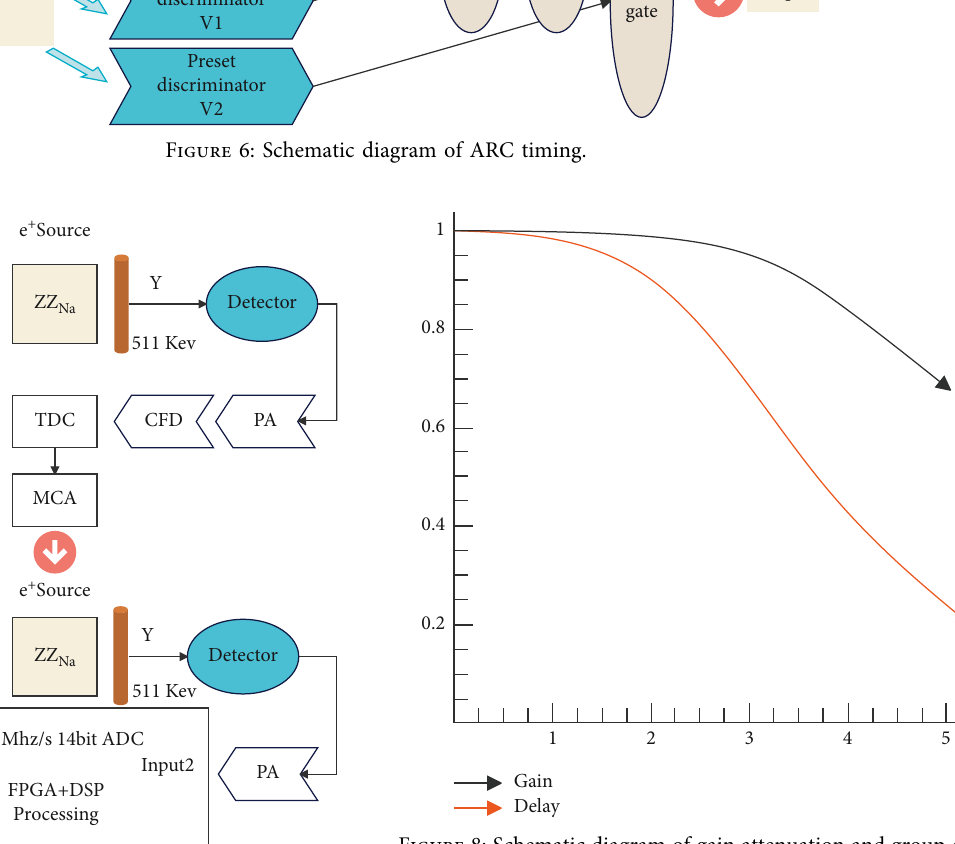
Figure 7: Schematic diagram of digital constant ratio timing.